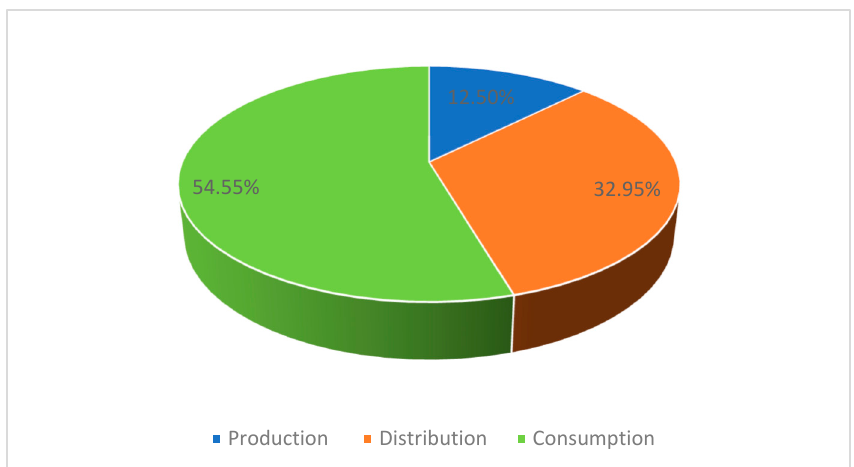
Figure 7. Sectoral distribution of articles published in Scopus on the topic of digitalization in energy.